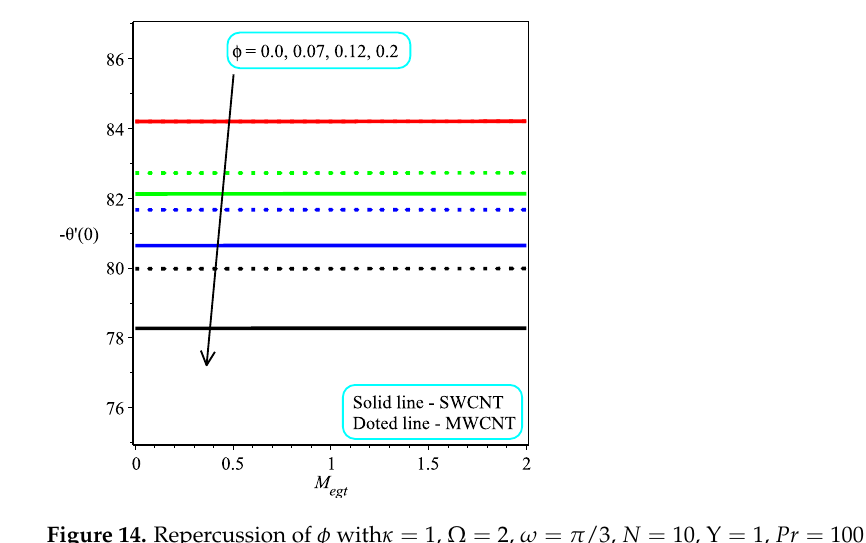
Figure 14. Repercussion of φ with κ = 1, Ω = 2, ω = π /3, N = 10, Υ = 1, Pr = 100 on − θ (cid:48) ( 0 )